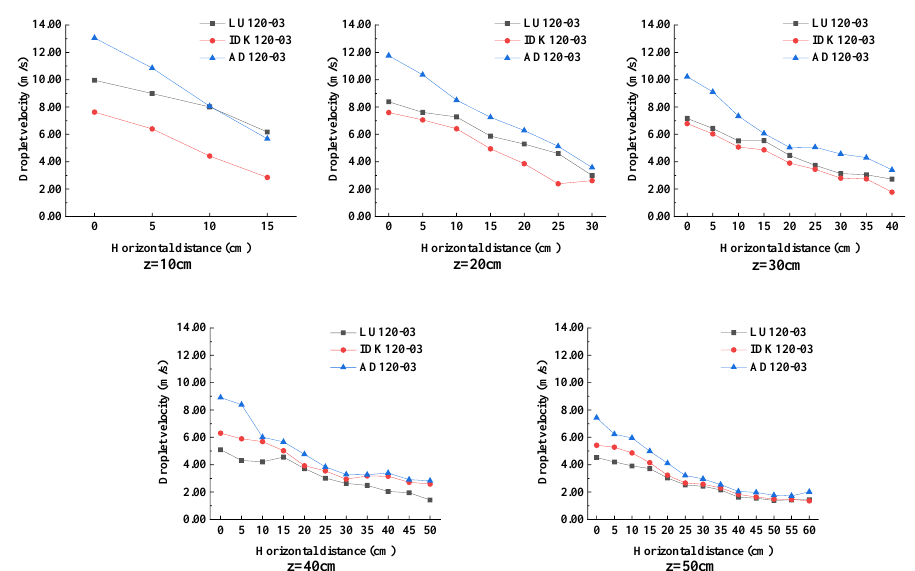
Figure 11. Horizontal direction droplet velocity V X distribution in different